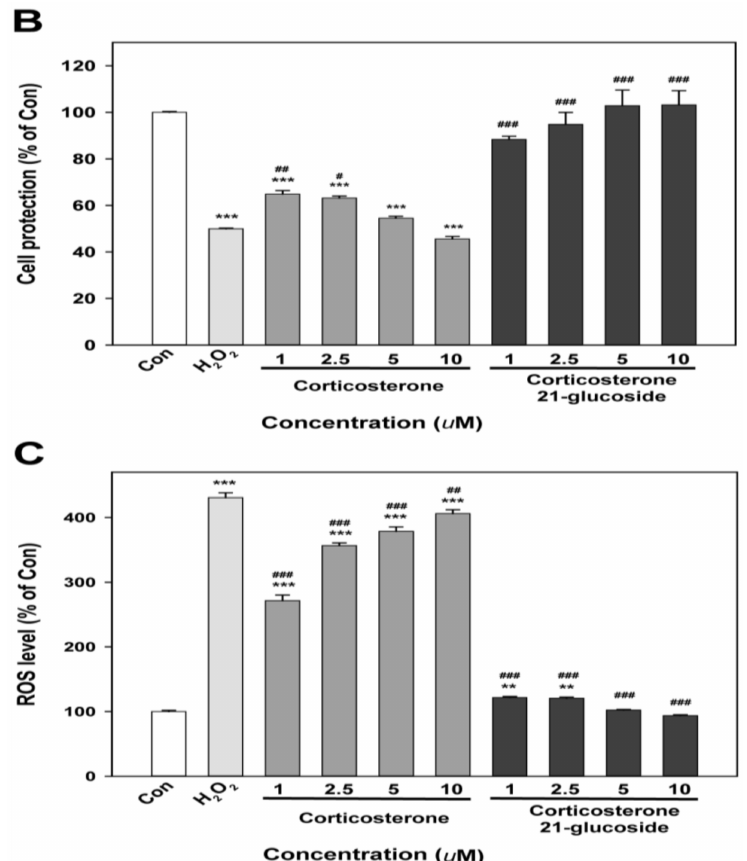
Figure 5. Effects of corticosterone and corticosterone 21-glucoside on SH-SY5Y neuroblastoma cell line. ( A ) Cell viability; ( B ) Cell protection on H 2 O 2 treated cells; ( C ) Reactive oxygen species